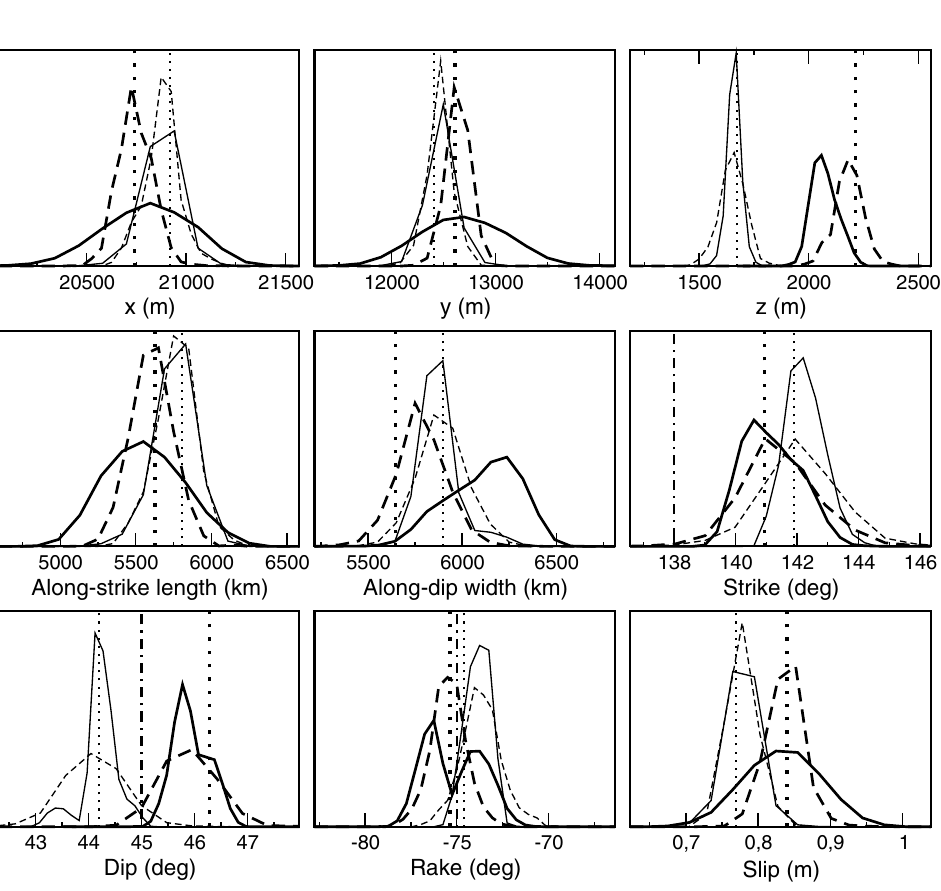
Fig. 5. PDFs of inferred fault parameters in the HHS (thin lines) and LHS (thick lines): dashed lines, bootstrap- ping; solid lines, NAB. Vertical dotted lines show ASA best-fit values; vertical dash-dotted lines indicate true parameter values. Uniform-slip